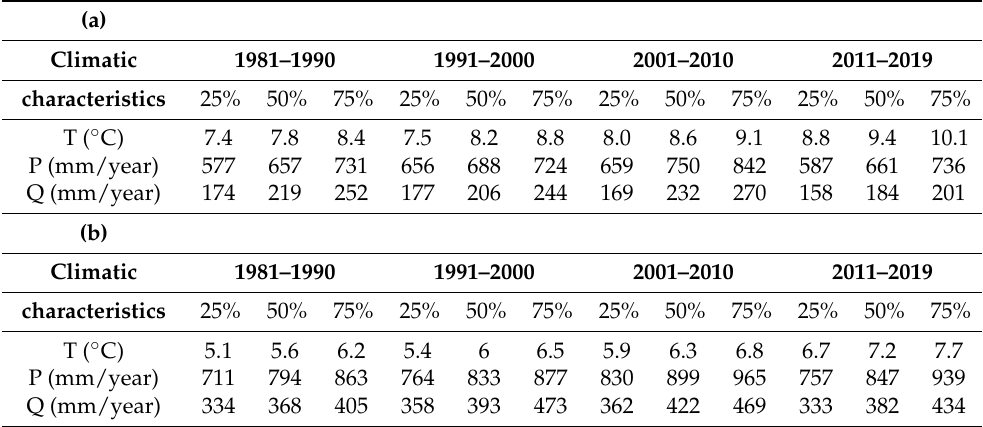
Table 2. The medians (50%) and percentiles (25% and 75%) of the long-term mean annual precipitation (P), air temperature (T), and runoff (Q) averaged over four decades (a) for the river basins with a mean elevation < 435 m a.s.l., (b) for the river basins with a mean elevation > 435 m